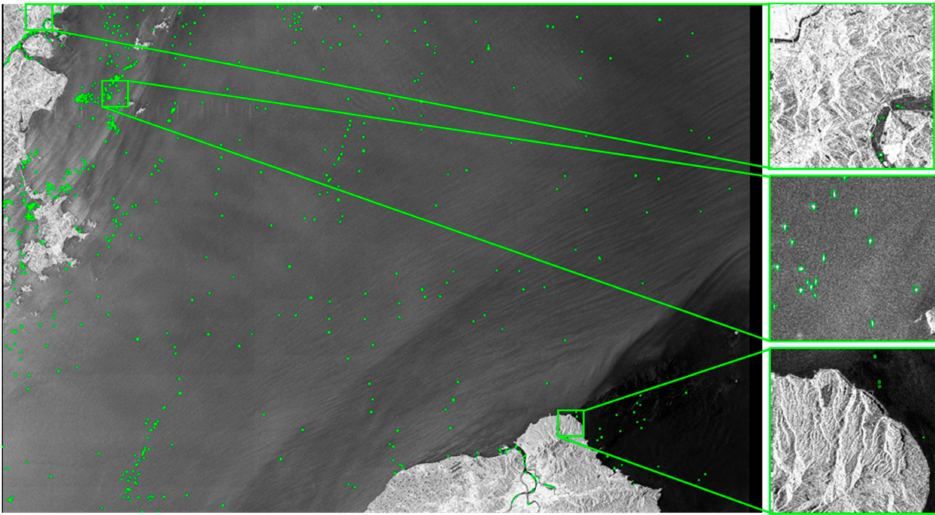
Figure 8. Ship ground truth labels of the 11.jpg. Real ships are marked in green